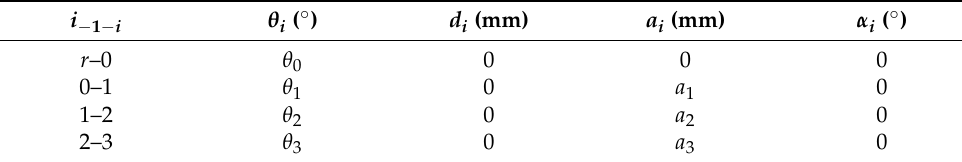
Table 1. D-H parameters